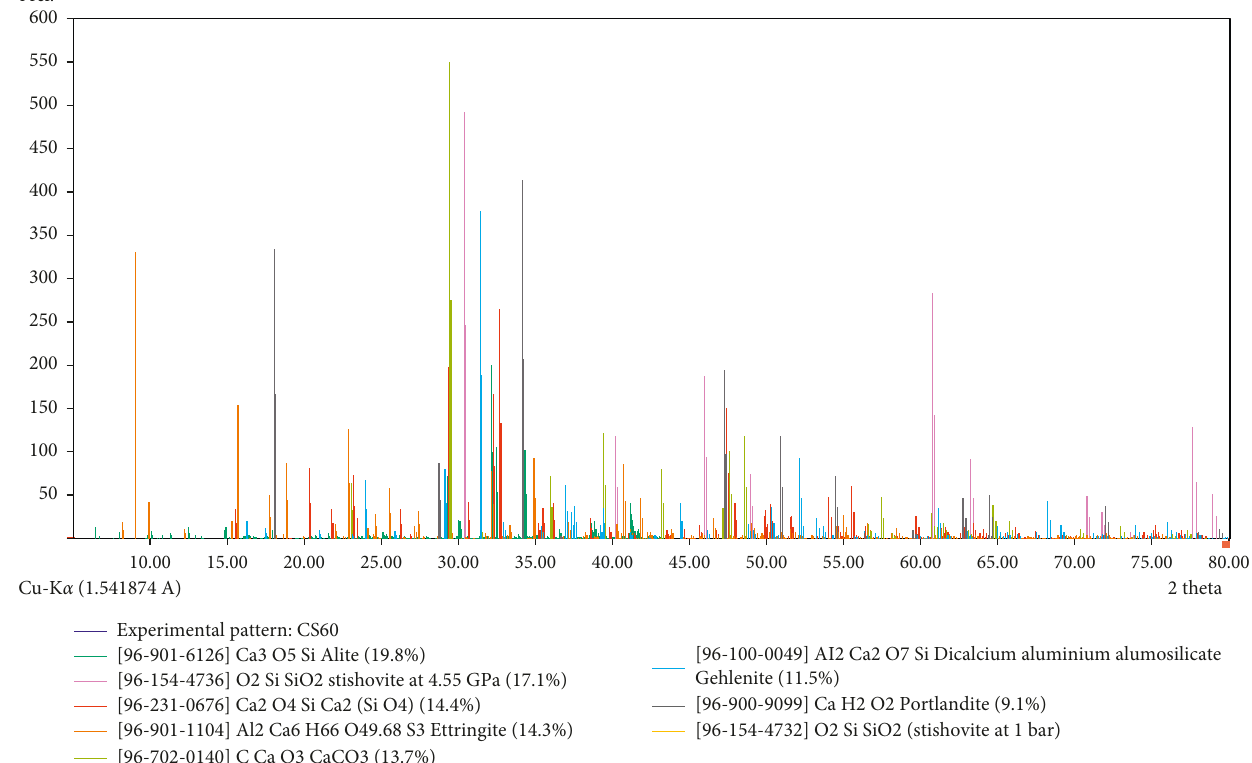
Figure 12: X-ray diffractogram of the mix CS60 at 28